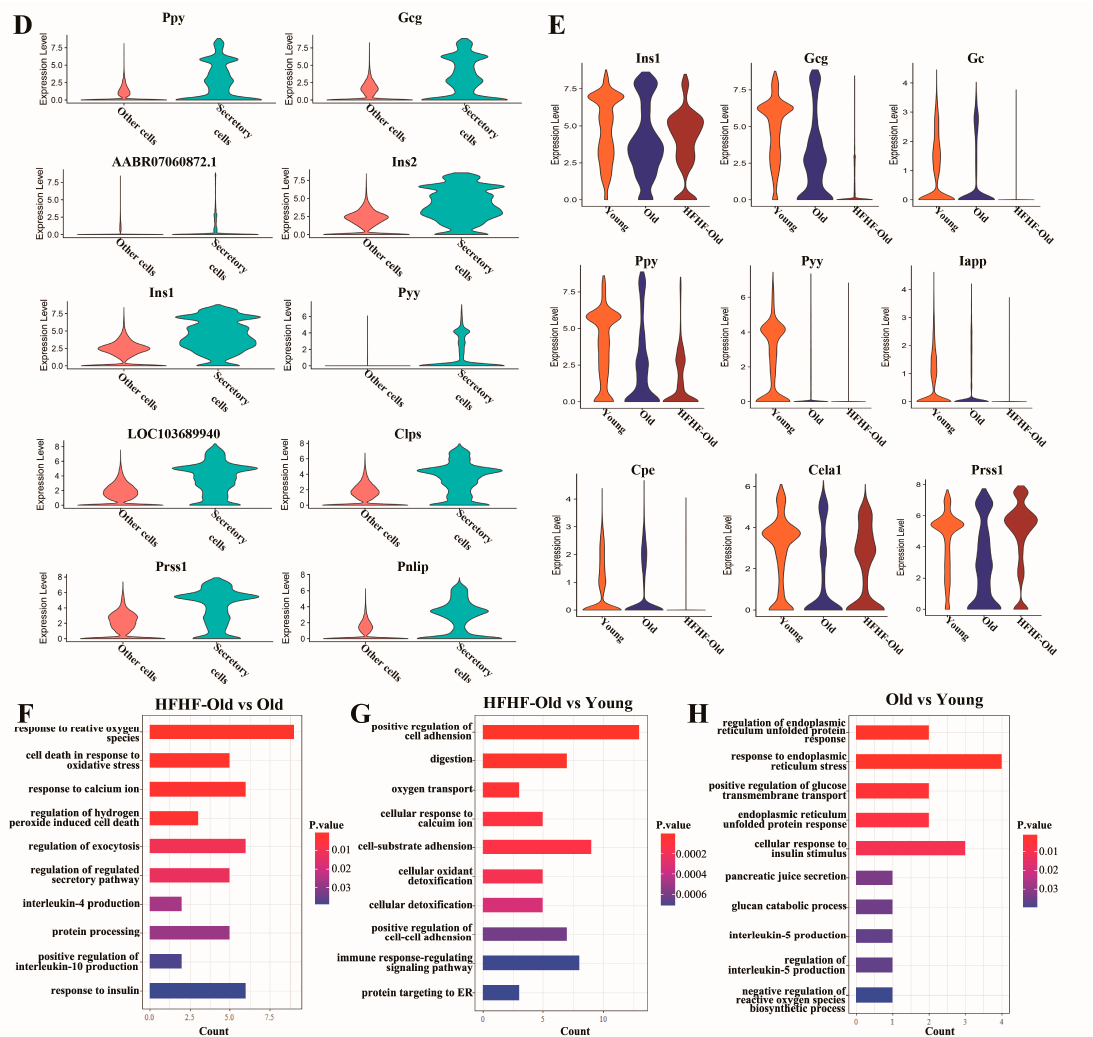
Figure 5. Distinct cell populations with transcriptional signatures in pancreatic secretory cells determined by a scRNA-Seq analysis of diabetic rats. ( A ) UMAP plot characterizing the differences in pancreatic cell distribution at the beginning (young) and after 18 months (HFHF-old, old) of diet feeding. Each point represents one cell. The distance between the two points is determined by the Pearson correlation of the 500 most highly expressed genes in each cell. Cell identity is recognized by the expression of marker genes. ( B ) UMAP plot of the marker gene expression in different cell types. ( C ) The number of different pancreatic cells at the beginning (young) and after 18 months (HFHF-old, old) of diet feeding. ( D ) Violin diagram of top 10 genes highly expressed in pancreatic secretory cells. ( E ) Violin diagram of secretory function-related gene expression in secretory cells among HFHF-old (HFHF, 18 months), old (control, 18 months), and young (baseline) groups. ( F – H ) Gene Ontology terms of upregulated enrichment obtained in secretory cells after a pairwise comparison of three groups ( p <